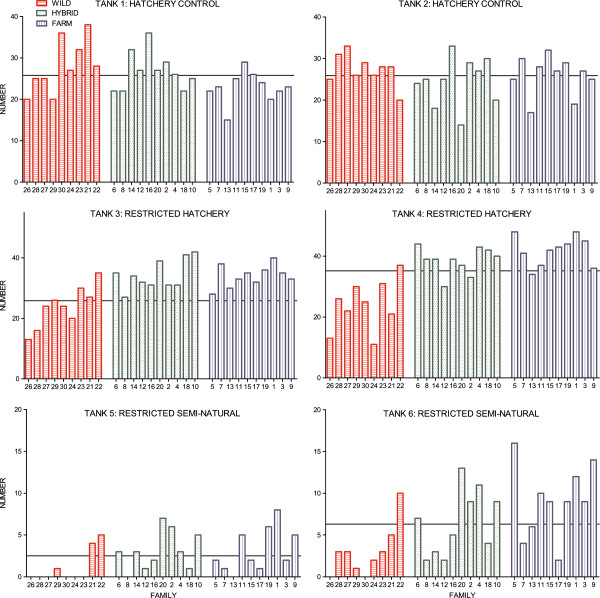
Family representation in all six tanks, experiment II. Number of sampled individuals from each farmed, hybrid and wild family, in all six tanks. Mortality was low in the hatchery control treatment, thus at the time of sampling 750 individuals were randomly selected for parental assignment. In the restricted hatchery treatment and the restricted semi-natural treatment all individuals were sampled and identified to family. Families within each group are ranked by their egg size in increasing order, due to the positive relationship between egg size and survival. Lines represent the expected number of individuals/family in each tank, assuming all 29 families were sampled/survived equally. All families were sampled within their expected frequencies in the hatchery control treatment where mortality was low. Mortality were higher in the restricted semi-natural treatment than in the restricted hatchery treatment, and wild salmon displayed significantly higher mortality rates than the hybrid and farmed salmon in both treatments.